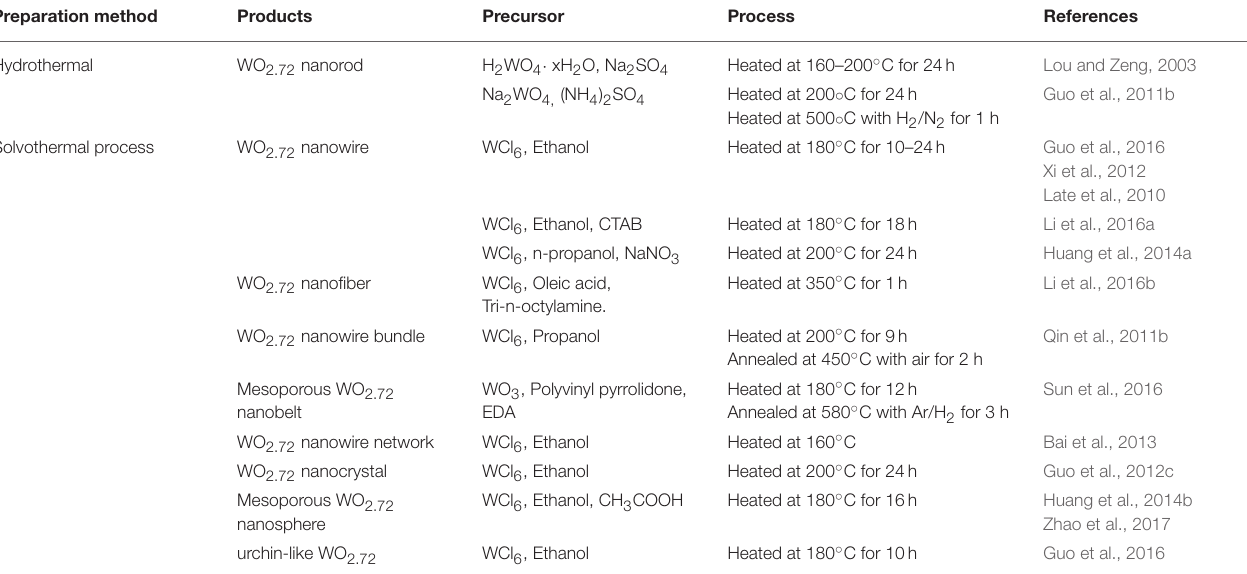
TABLE 3 | Preparations of non-stoichiometric tungsten-oxide (WO 2.72 ) by hydrothermal and solvothermal